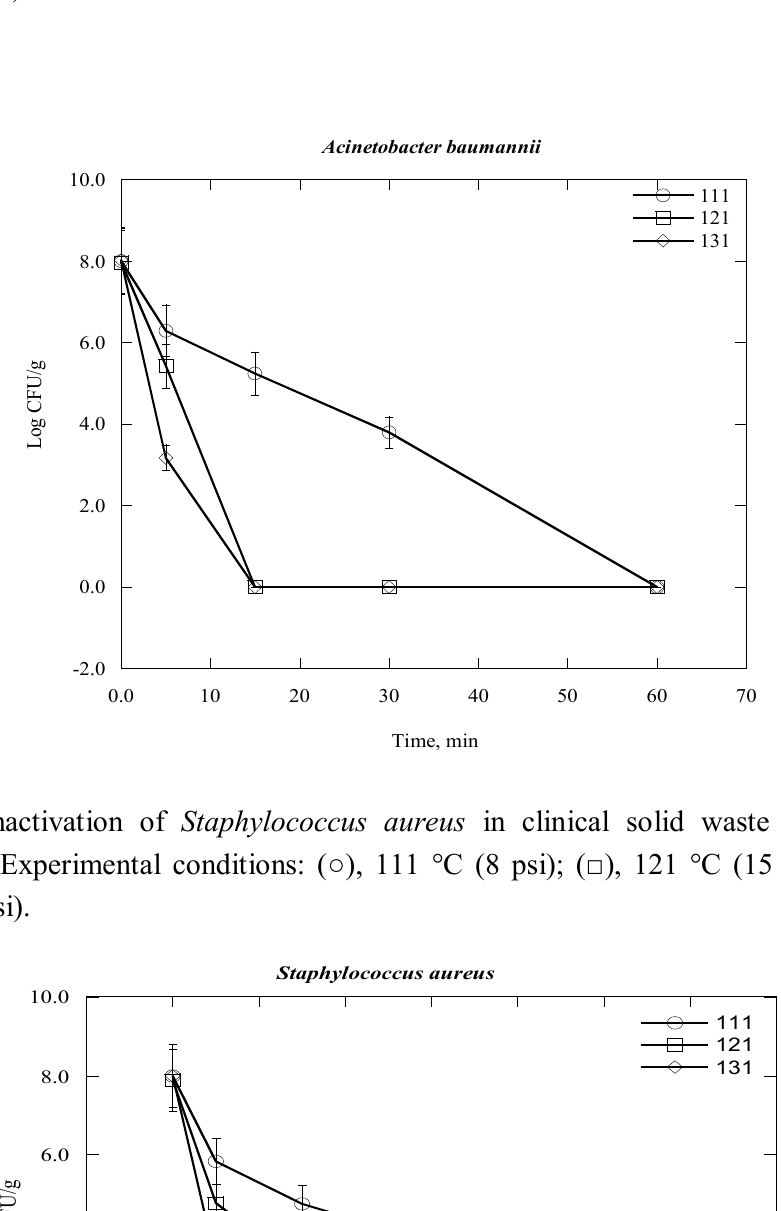
Figure 3. Inactivation of Actinetobacter baumannii in clinical solid waste using steam sterilization. Experimental conditions: (○), 111 °C (8 psi); (□), 121 °C (15 psi) and (◊), 131 °C (27 psi).